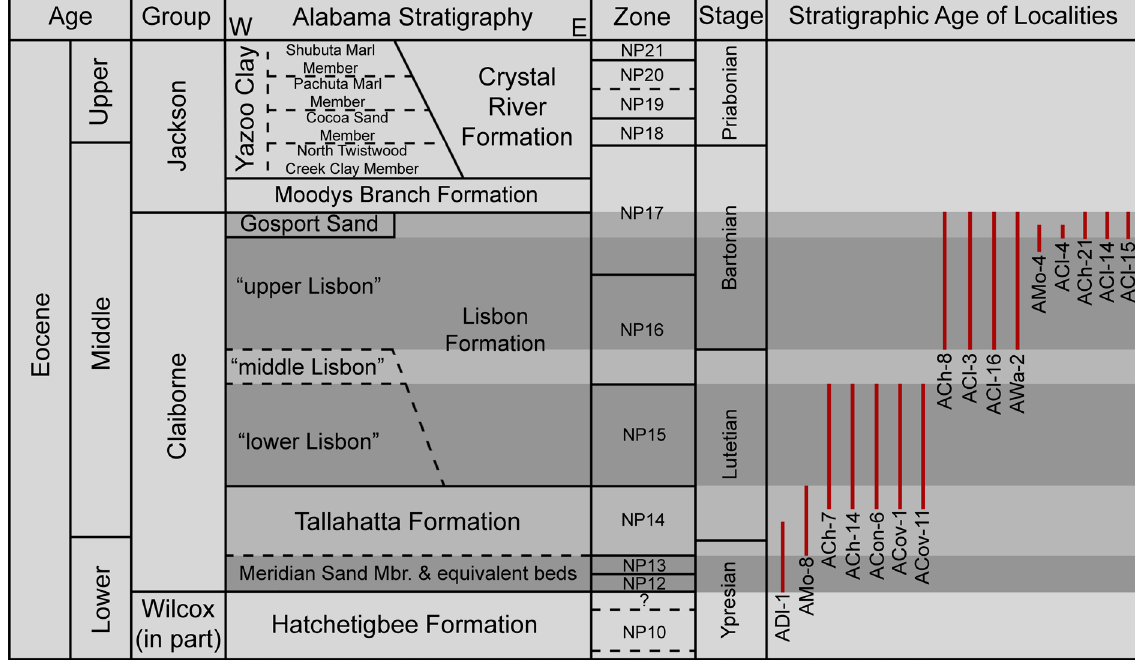
Fig. 1. Eocene surface stratigraphy in Alabama and the stratigraphic age of Claiborne Group localities. Vertical red lines indicate the stratigraphic unit(s) exposed at each locality. Abbreviations: E = east; Mbr. = Member; NP = Nannoplankton Zone; W =